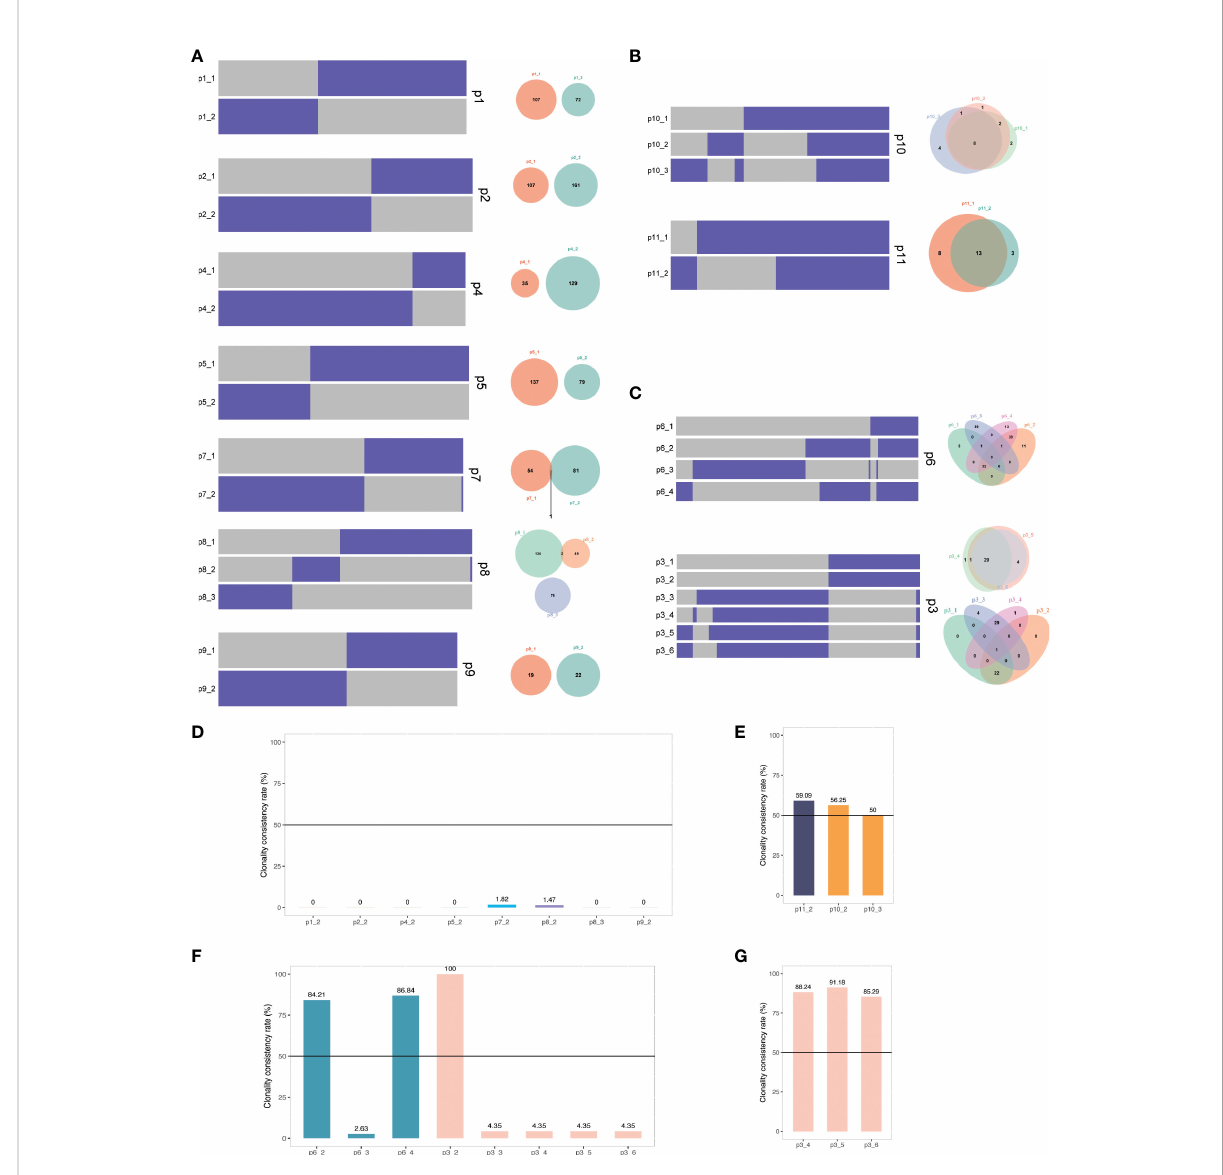
FIGURE 4 The clonal relatedness of primary and recurrent tumors (A) Heat maps show the presence (purple) or absence (grey) of mutations in primary and recurrent tumors of p1, 2, 4, 5, 7, 8, and 9. Venn diagrams present the total number of mutations unique or shared between primary and recurrent tumors. (B) Heat maps and Venn diagrams of p10 and p11. (C) Heat maps and Venn diagrams of p3 and p6. (D) Clonality consistency rate of recurrent tumors compared with the primary tumors. (E) Clonality consistency rate of p10 and p11. (F) Clonality consistency rate of p3 and p6. (G) Clonality consistency rate of p3 recurrent tumors compared with the third tumor (50%). Black lines indicate the cutoff value to de fi ne clonal